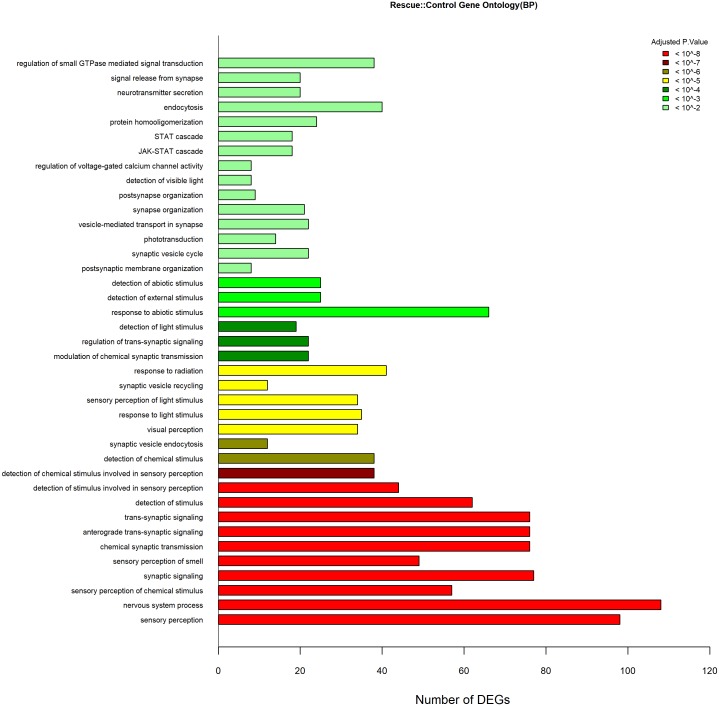
GO Analyses Rescue Vs. Control.Gene Ontology biological process enrichment results (P < 0.01) from lepa rescue compared to control treatments representing n = 39 terms. Color scale reflects adjusted p.value; the x-axis denotes the number of DEGs that map to each enriched term.